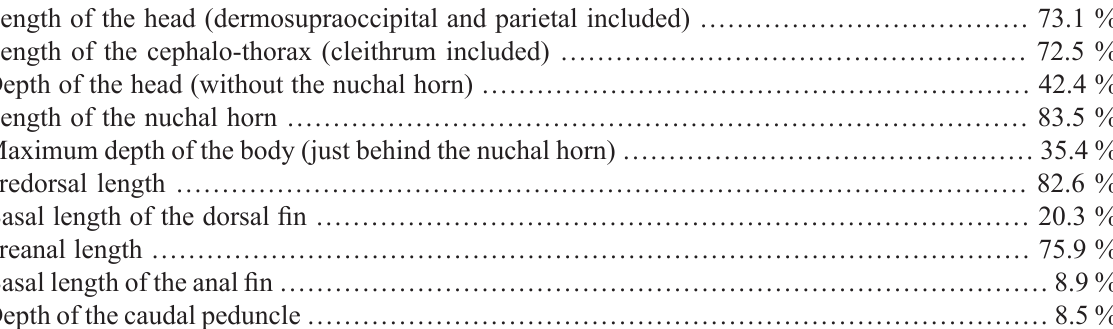
Osteology 1. The skull (Fig. 19)